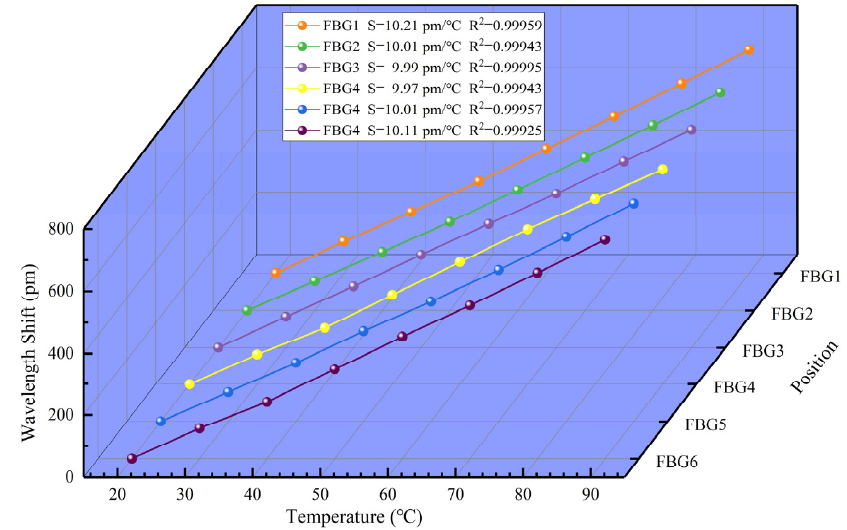
Figure 4. Normalized spectral reflectance of sensor group 1 under temperature experiment: ( a ) FBG1 at different temperatures; ( b ) FBG2 at different temperatures.